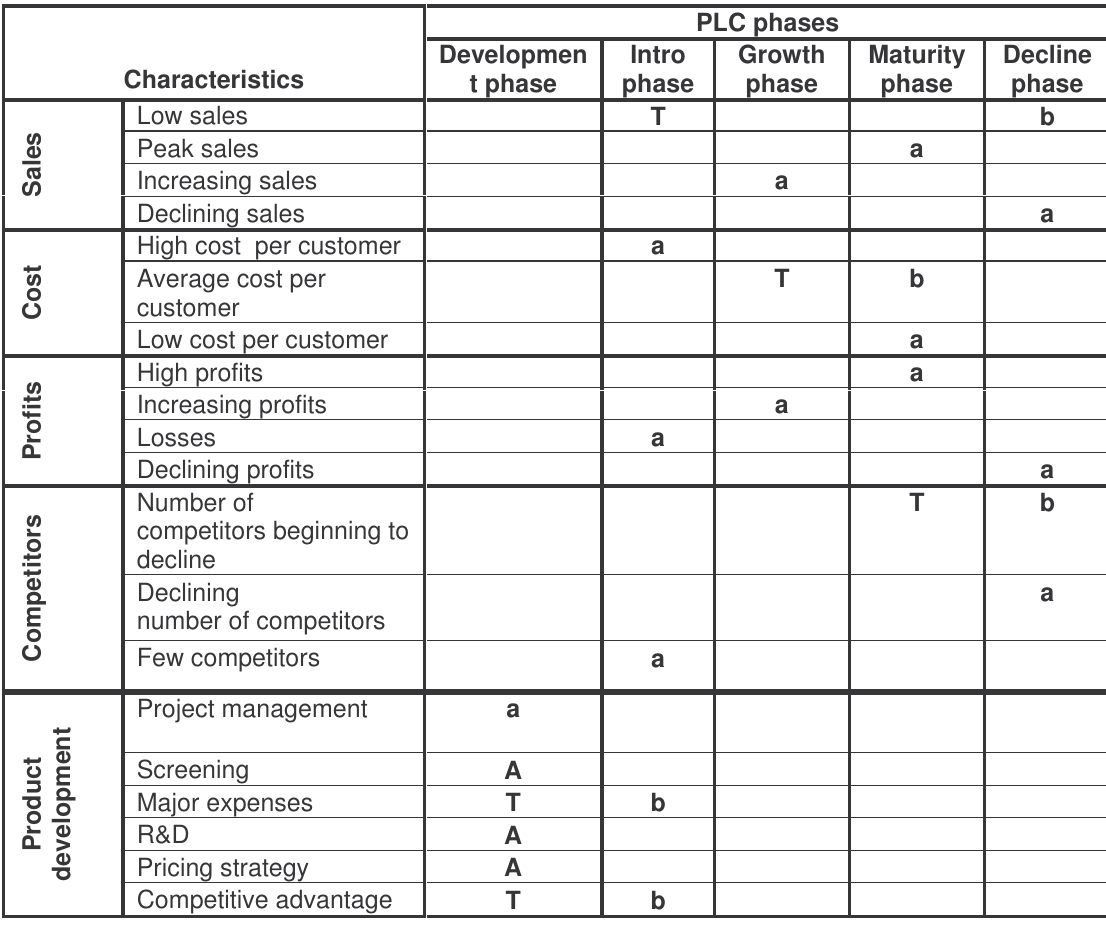
Comparison of the total sample’s responses of characteristics with the theory in each of the PLC phases Characteristics